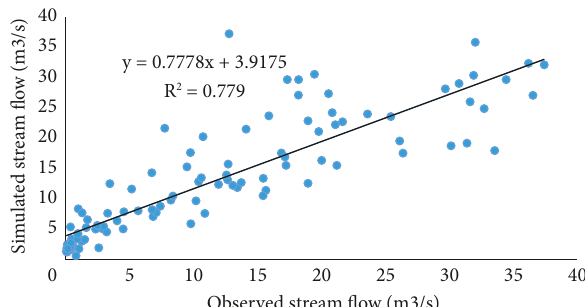
y = 1.0403x + 86.817